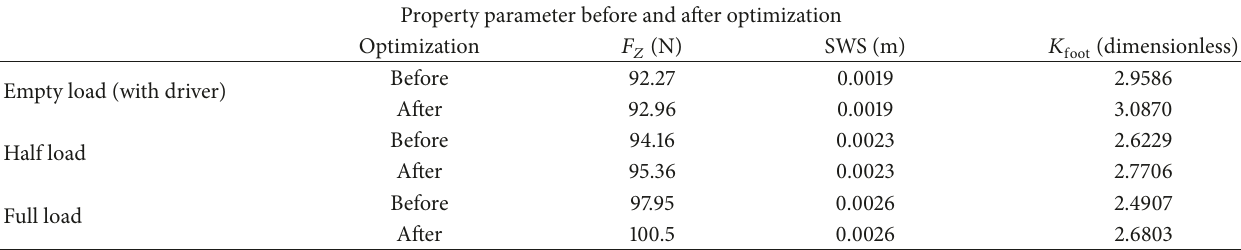
Table 4: Property parameter before and after